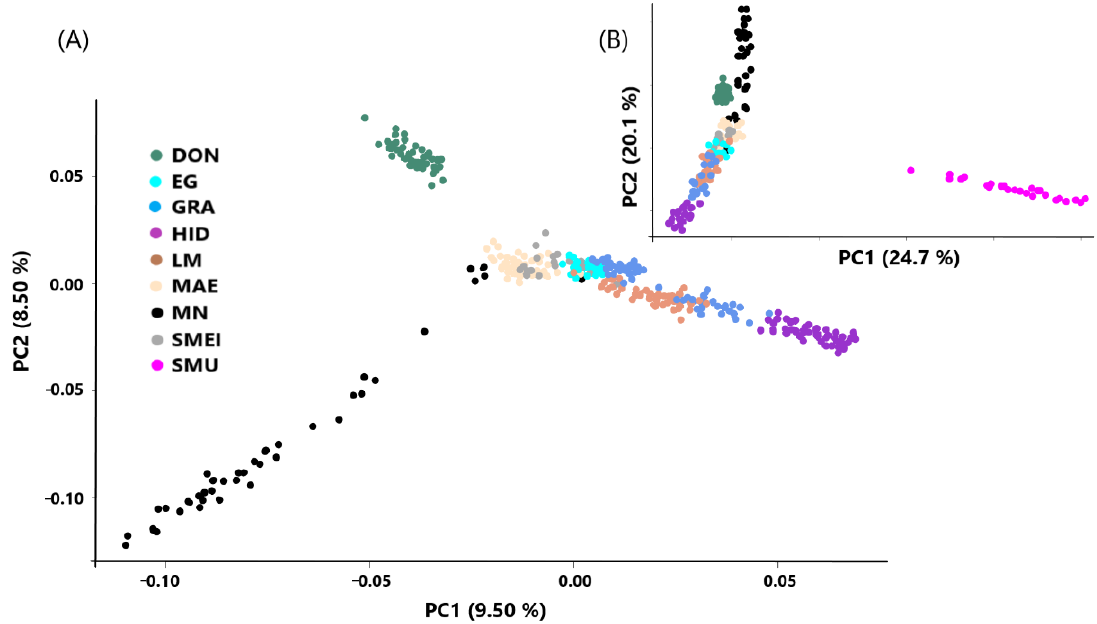
Figure 3. Principal component analysis of the Spanish Merino lines and the Black Merino breeds population using the Mouflon ( A ) and without ( B ) as outgroup. ( A ) Genetic lines within the Spanish Merino breed: DON (Donoso), EG (Egea), GRA (Granda), HID (Hidalgo), MAE (Maesso), LM (López ‐ Montenegro), SMEI (Spanish Merino from Industrial Breeding). Outgroup species: SMU (Mouflon). ( B ) Detailed PCA of the Spanish Merino genetic lines and the Black Merino without the Mouflon.